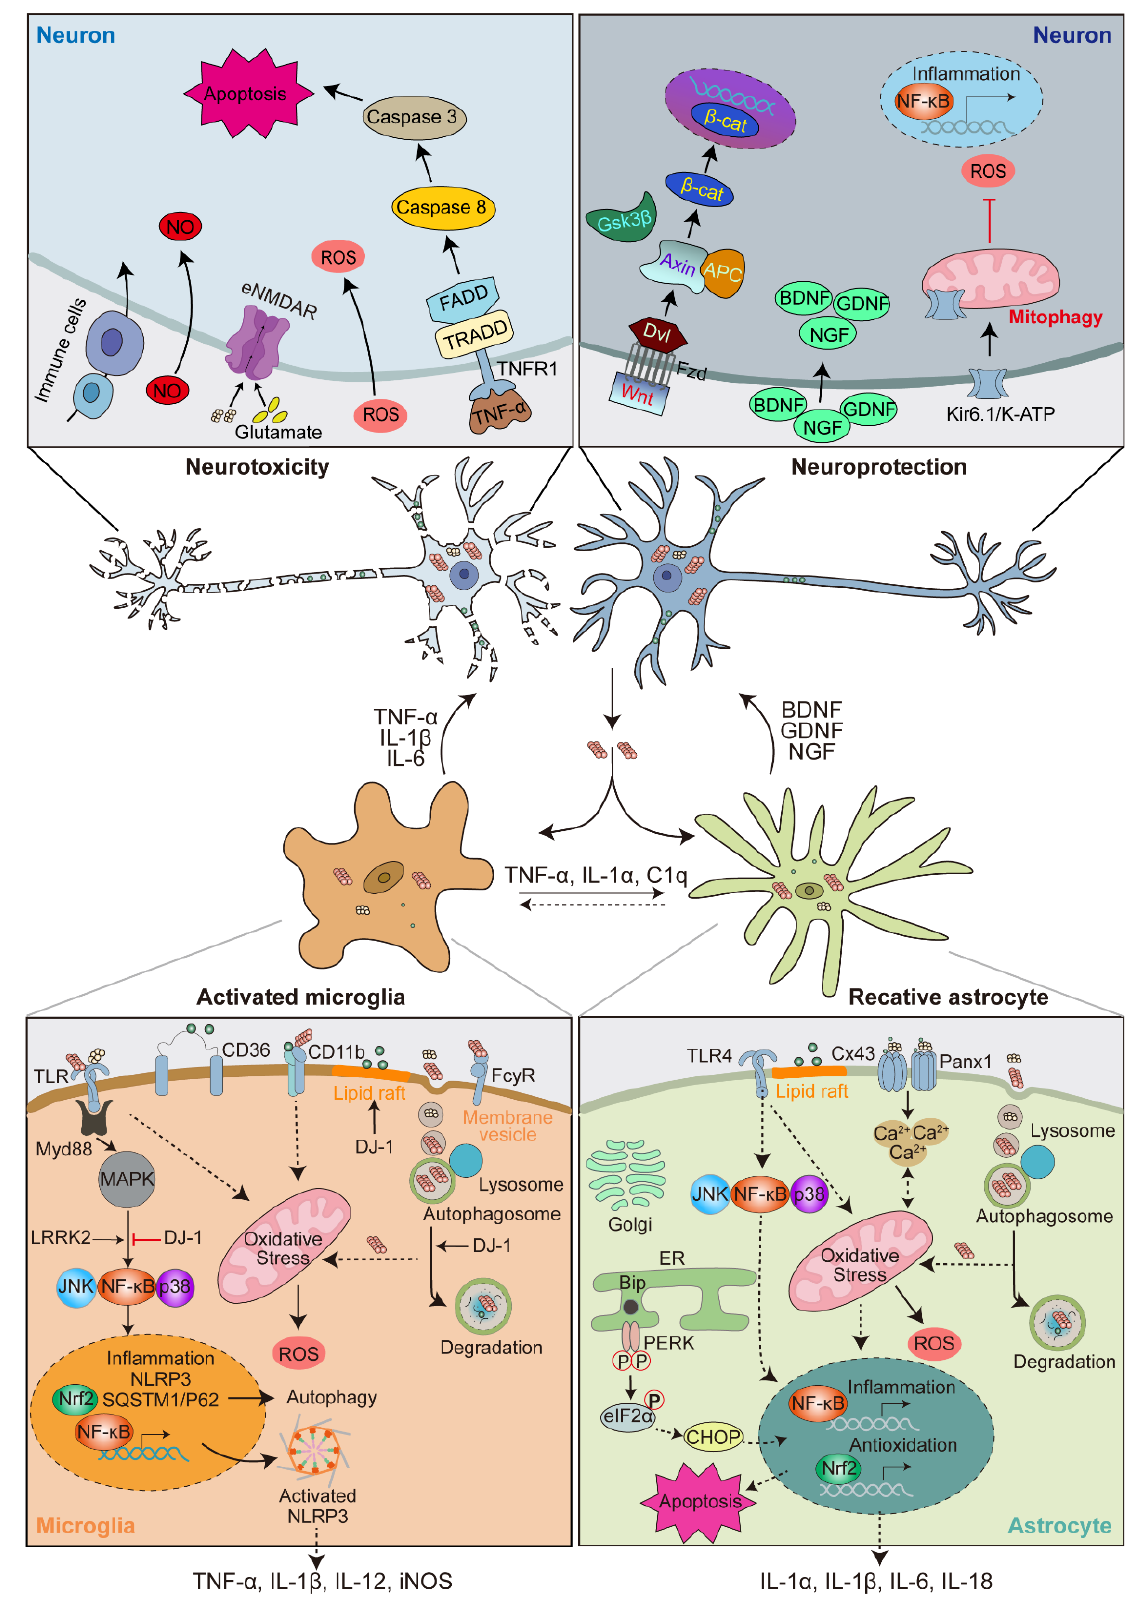
Figure 3. Neuron-glia crosstalk in regulating the pathogenesis of α -syn in PD. Neuronal released α -syn could transfer to and activate microglia and astrocyte, activated glia in turn perform neuroprotective or neurotoxic feedback to DA neuron. Bottom left: In microglia, uptake of α -syn triggers various signaling cascades. Upon α -syn binding to heterodimer TLR1/2 receptor, it interacts with adaptor molecule MyD88 and initiates sequential IRAK/TRAF6/TAK1 activation events, then leads to MAPK activation and nuclear translocation of NF- κB, JNK , and p38, which promote the tran- scription of pro-inflammatory cytokines including TNF- α, IL - 1β, IL -12, and inducible nitric oxide synthase (iNOS). TLR4 mediates α -syn-induced phagocytic activity, pro-inflammatory cytokine re- lease, and ROS production. TLR4-induced NF- κB signaling upregulates the expression of p62/SQSTM1 and promote autophagy. Nod-like receptor protein 3 (NLRP3) inflammasome is in- volved in the inflammatory response. DJ- 1 regulates α -syn phagocytosis, inflammatory responses, and degradation in microglia. LRRK2 positively regulates NF- κB inflammation pathway. Nrf2 was also reported to be involved in α -syn- induced microglia activation. Bottom right: In astrocyte, α -